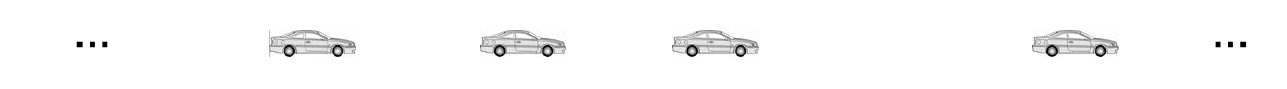
 . The initialization rules of the cellular state are as follows: (1) Position. At the initial time, there are a total of N vehicles on the road with a length of L . Assigning the same motion area l for all vehicles, and the initial position of